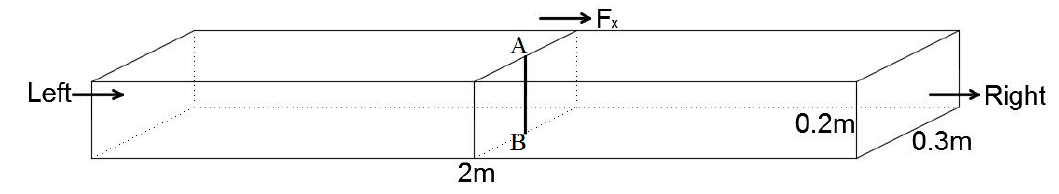
Figure 4. Schematic diagram of the periodical numerical flume.